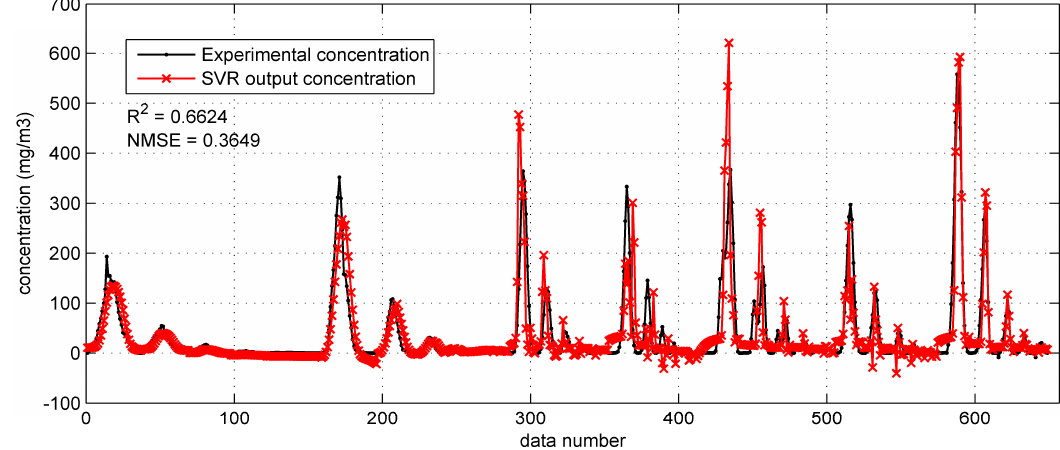
Figure 8. The prediction results of SVR with integrated Gaussian parameters on the Prairie Grass test set.